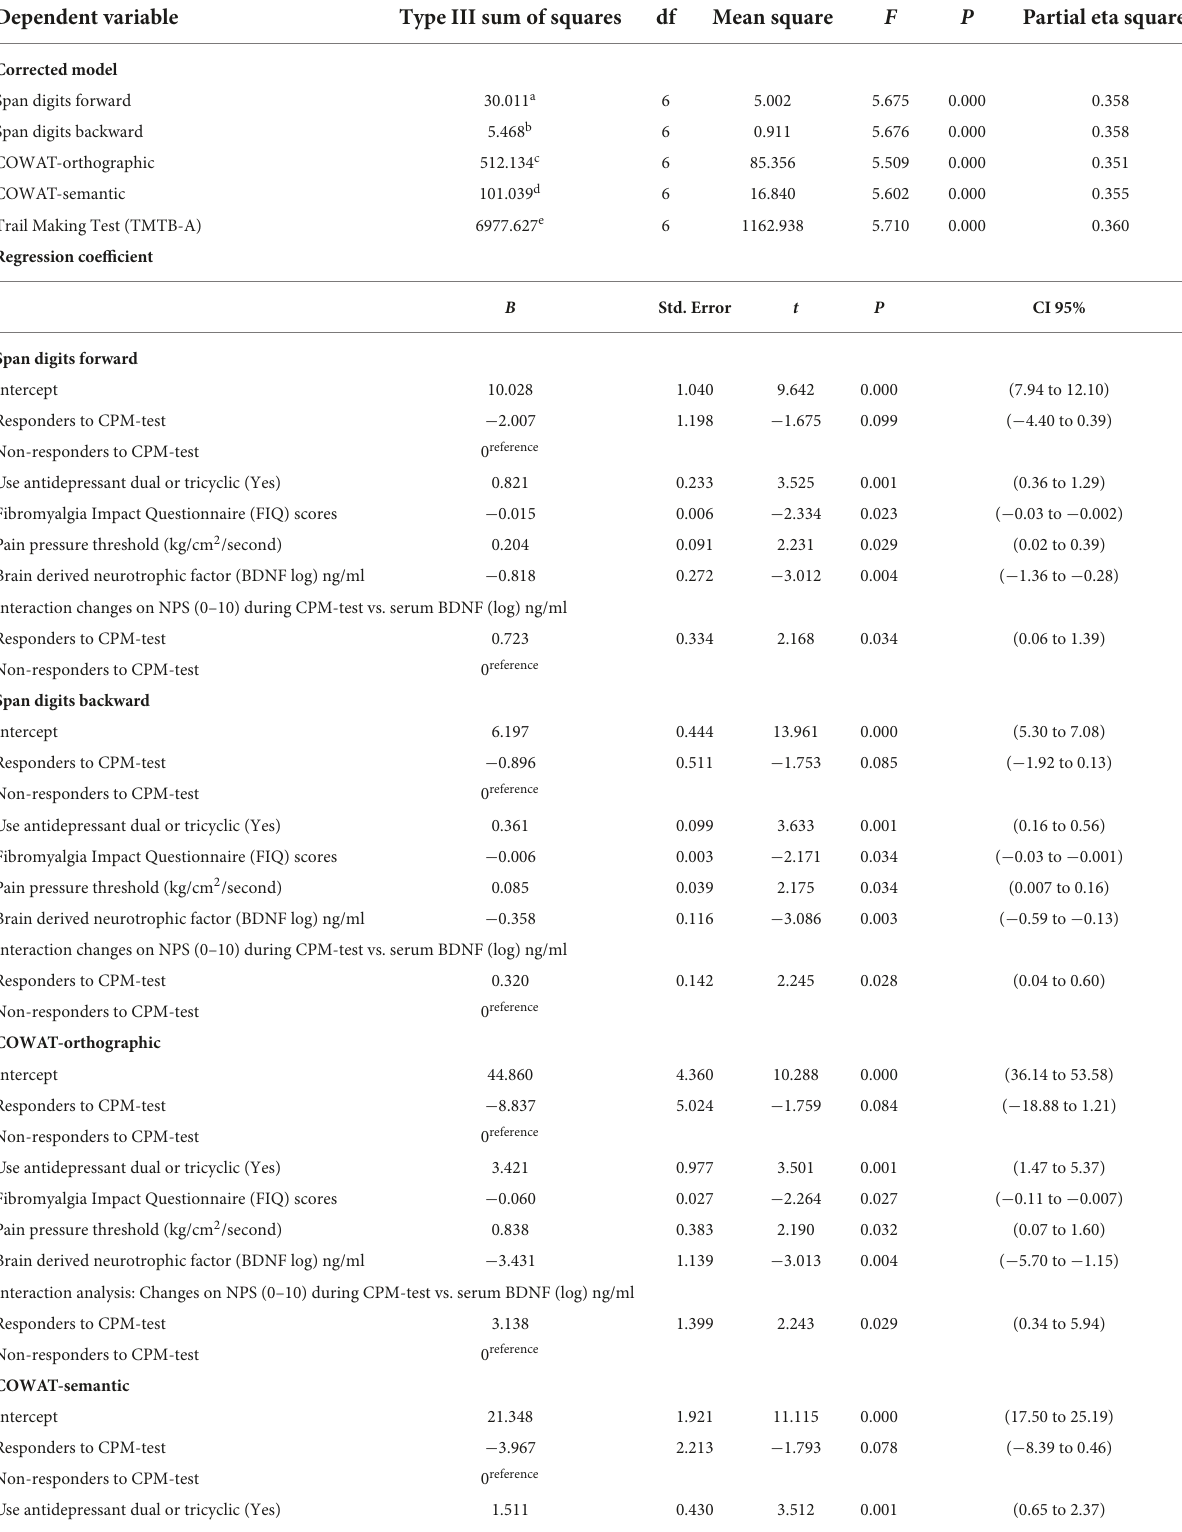
TABLE 5 Multilevel MANCOVA to assess the relationship between cognitive performance tests in responders and no responders according to change in NPS (0–10) during the CPM-test and related factors ( n =